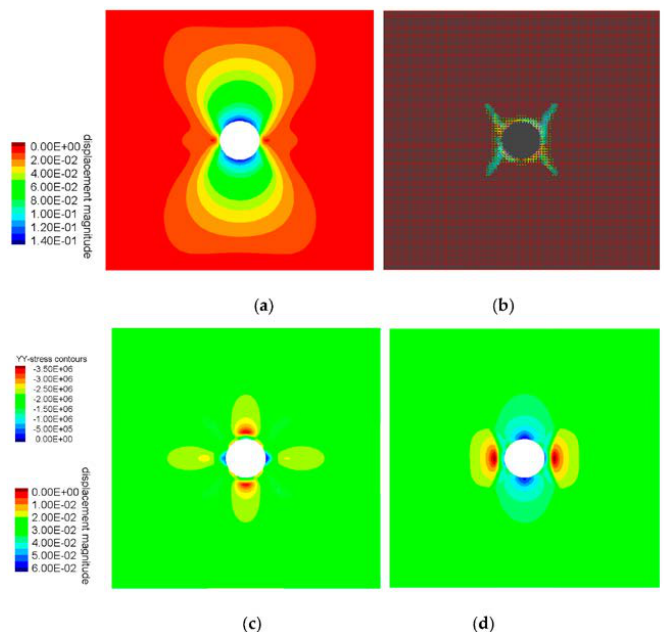
Figure 23. Simulation results for tunnel model with two joint sets (45° and − 45°) and κ = 1: ( a ) displacement contours [m], ( b ) plasticity state, ( c ) contour plot of horizontal stresses [Pa] and ( d ) contour plot of vertical stresses [Pa].